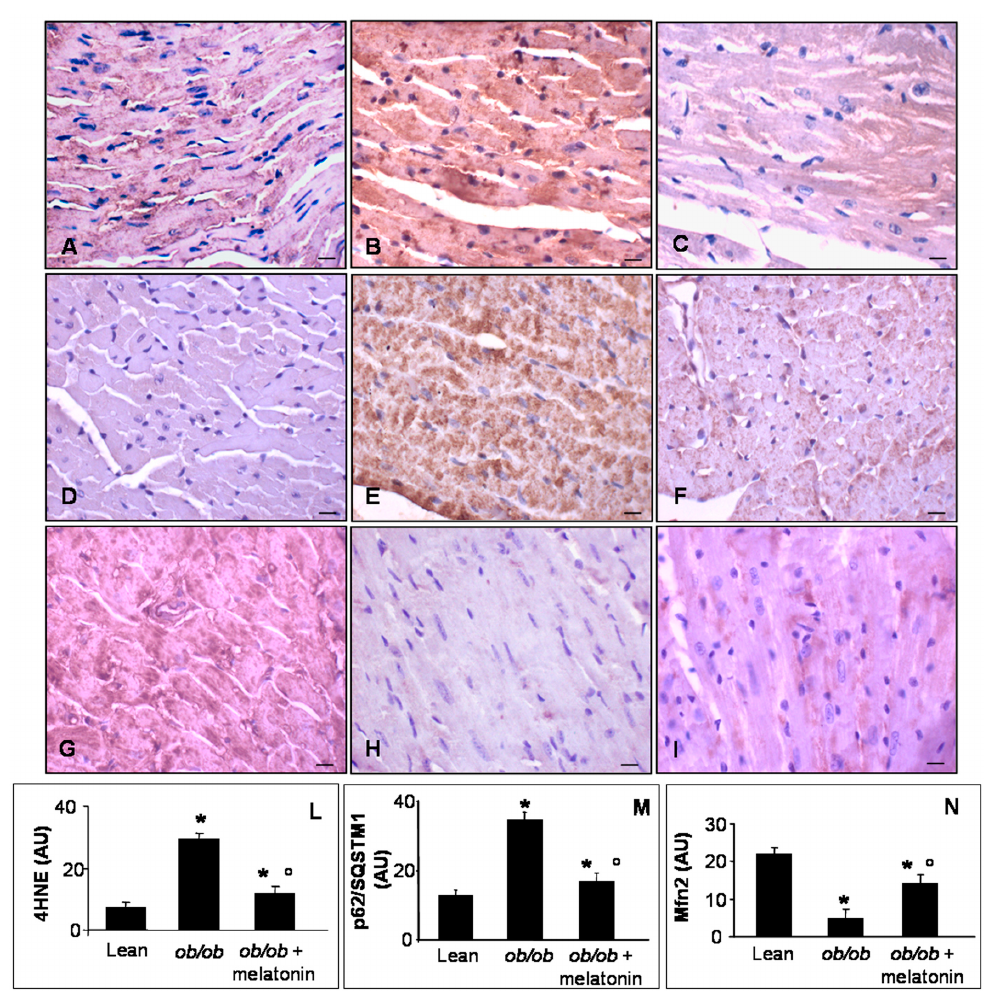
Figure 5. Heart lipid peroxidation, autophagy and mitochondrial health markers evaluation.